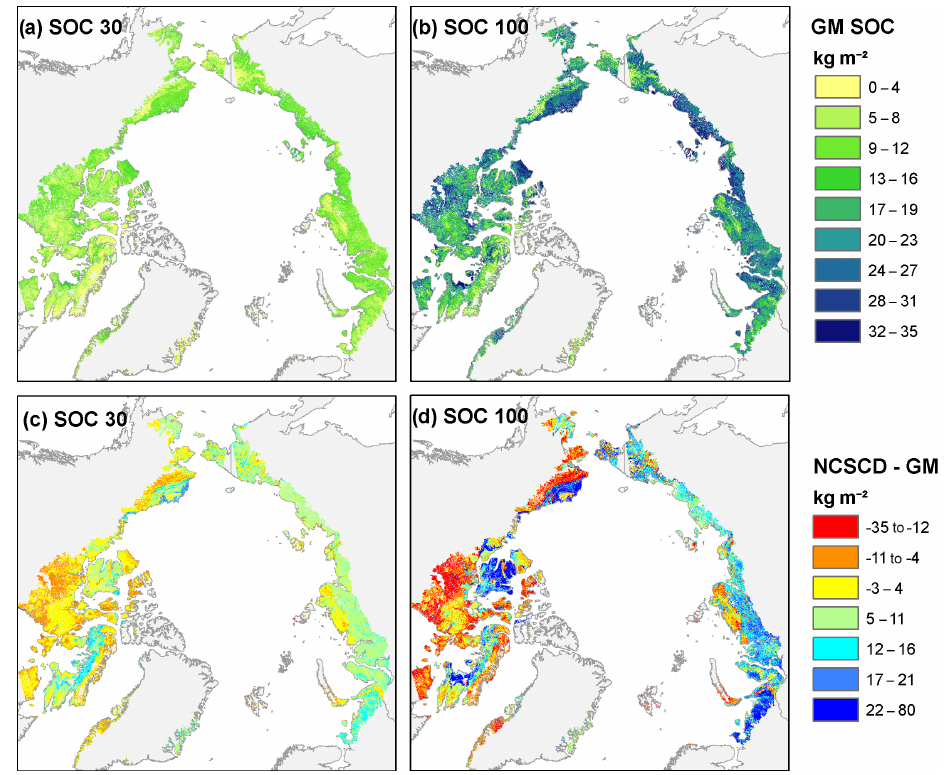
Figure 5. SOC results from ENVISAT ASAR GM (a) 0–30 and (b) 0–100cm, and SOC difference between NCSCD and ENVISAT ASAR GM (c) 0–30 and (d)